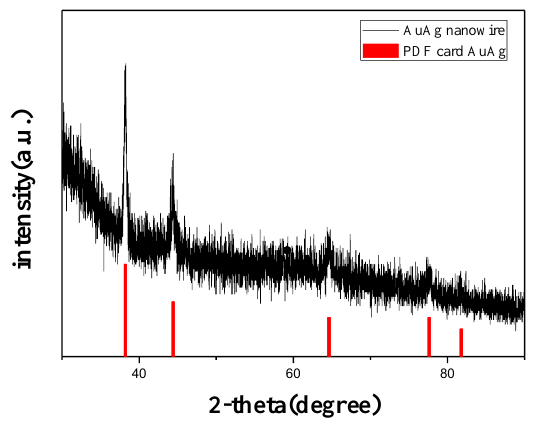
Figure 3. X-ray diffraction (XRD) pattern of Au-Ag NWs.